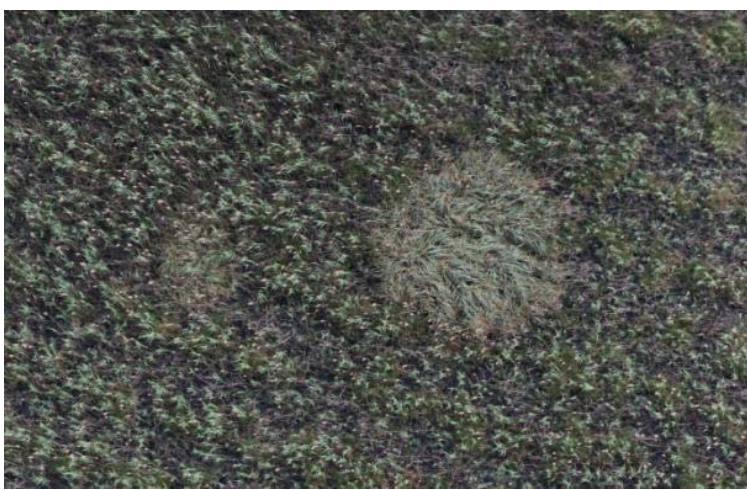
Figure 10. Nest ‐ like vegetation structures. The analysis of small or medium resolution images was made more difficult by the appearance of nest ‐ like vegetation structures, which could be easily recognized in images made with 0.7 cm spatial resolution.